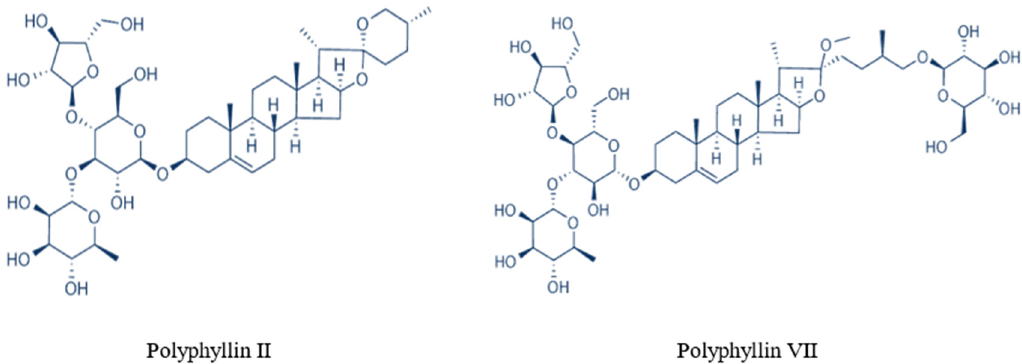
Figure 1. Chemical structures of two saponins.